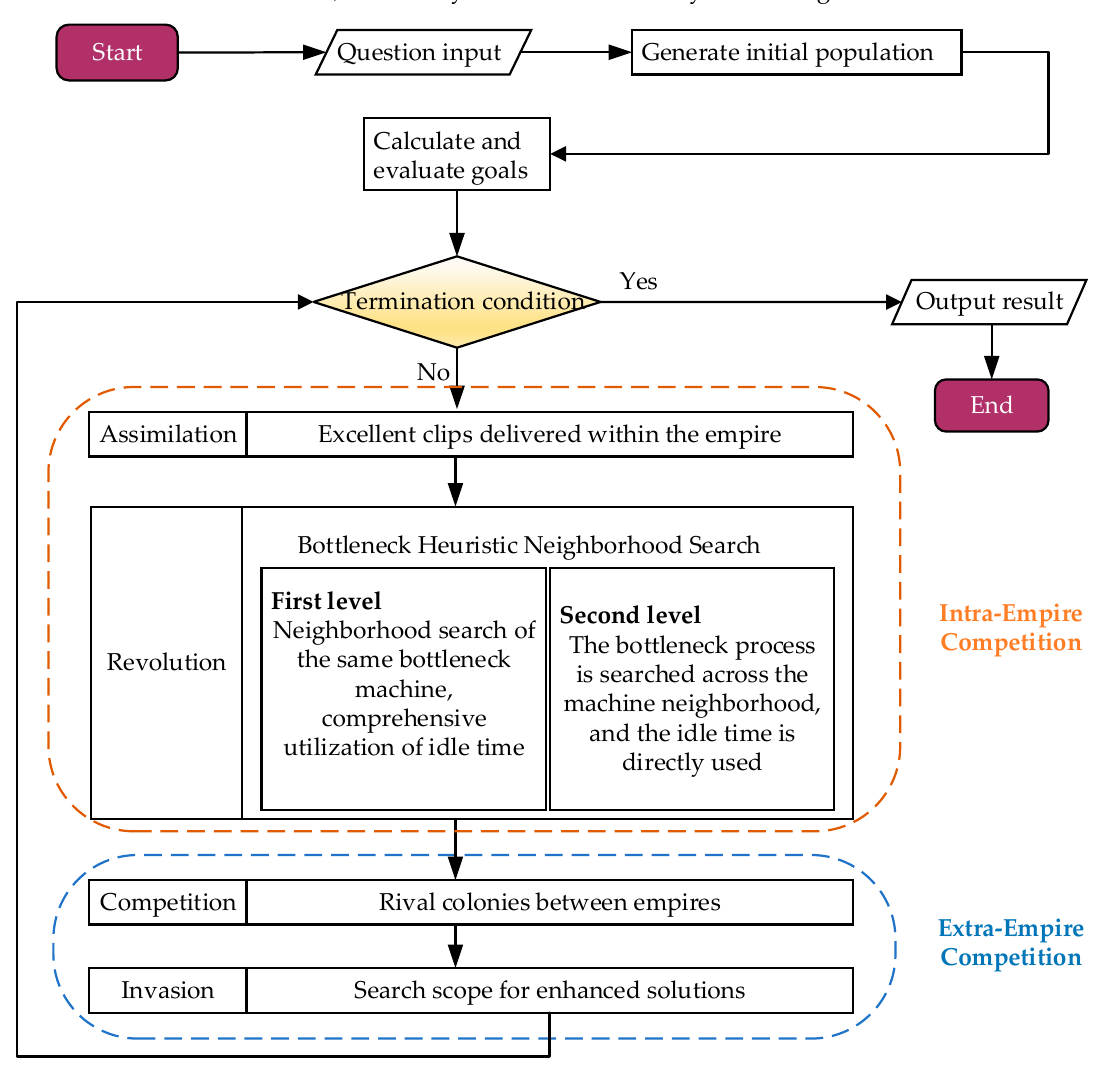
Figure 2. The framework of the hybrid algorithm.